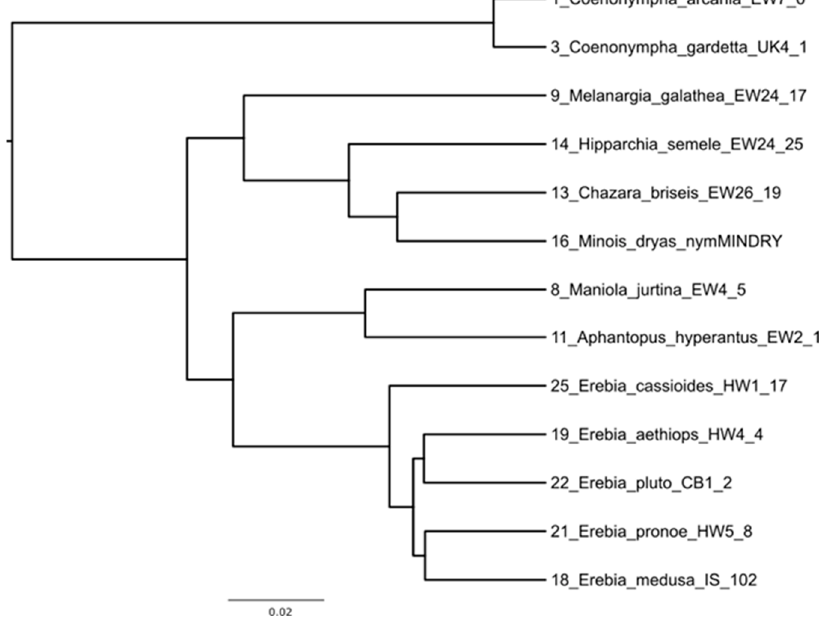
Figure A2. Pruned Bayesian tree of Satyrinae butterflies covering only species with examined cryoprotectant concentrations and supercooling ability.